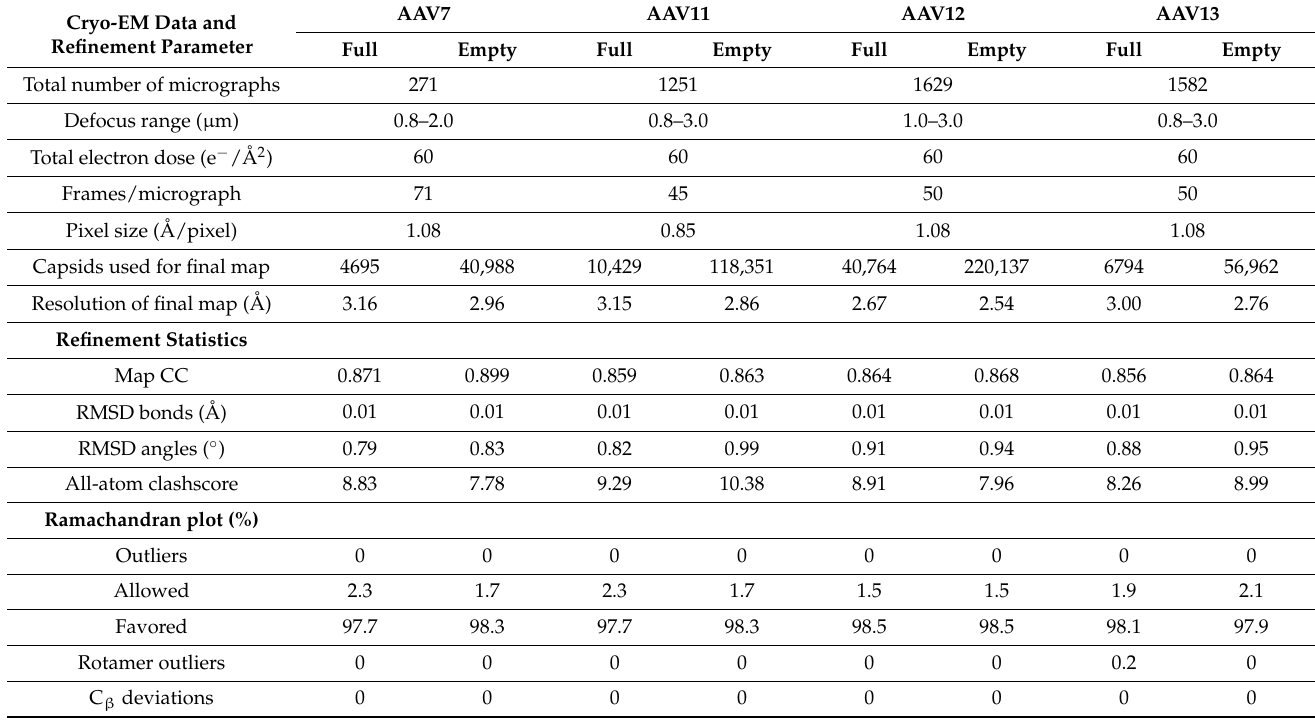
Table 1. Summary of data collection, image processing, and refinement